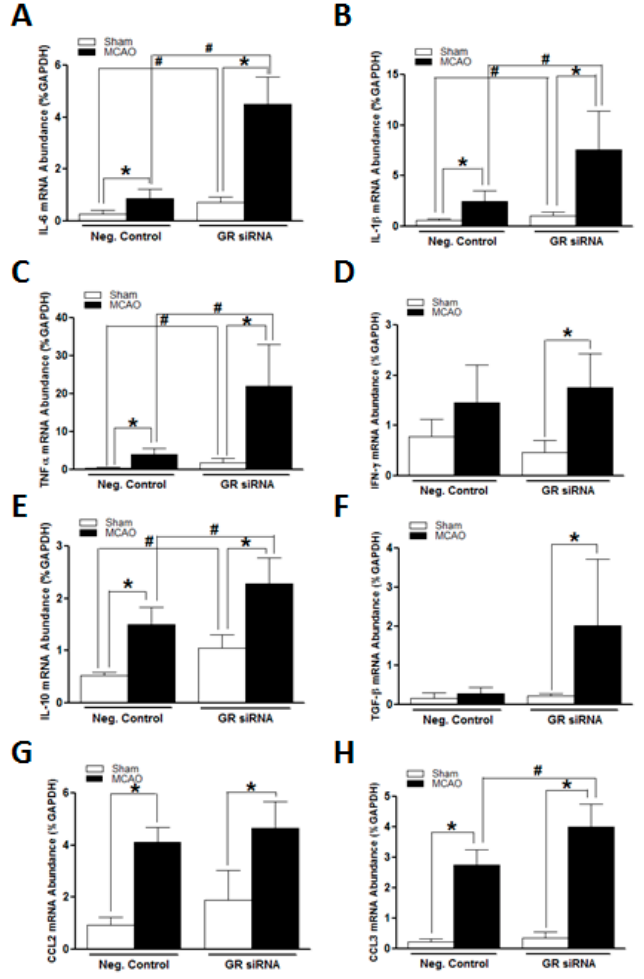
Figure 3. The GR repression induced heightened inflammatory responses in mice brains